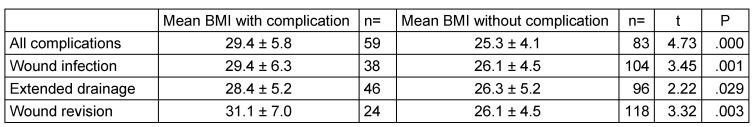
Influence of BMI on post-operative morbidity in ILND (n=137)